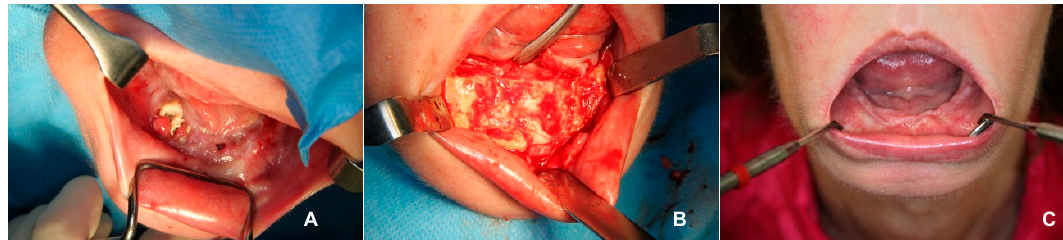
Figure 1. Photographs before, during and after surgery. ( A ) Multiple intraoral fistula and denuded bone; ( B ) Subperiosteal bone before closure of the surgical wound; ( C ) Intraoral view six weeks after surgery with closed mucosa.